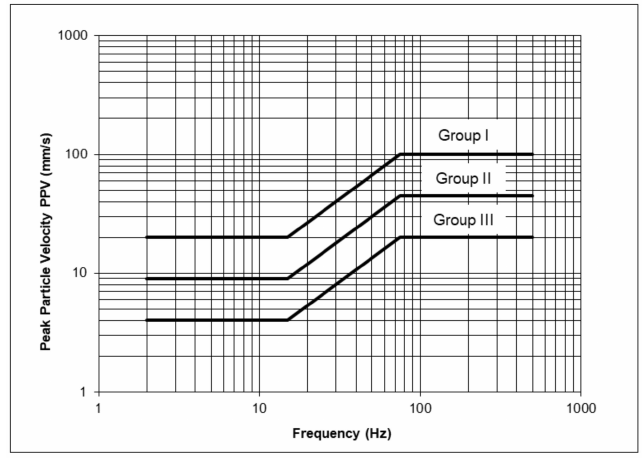
Figure 5. Vibration prevention